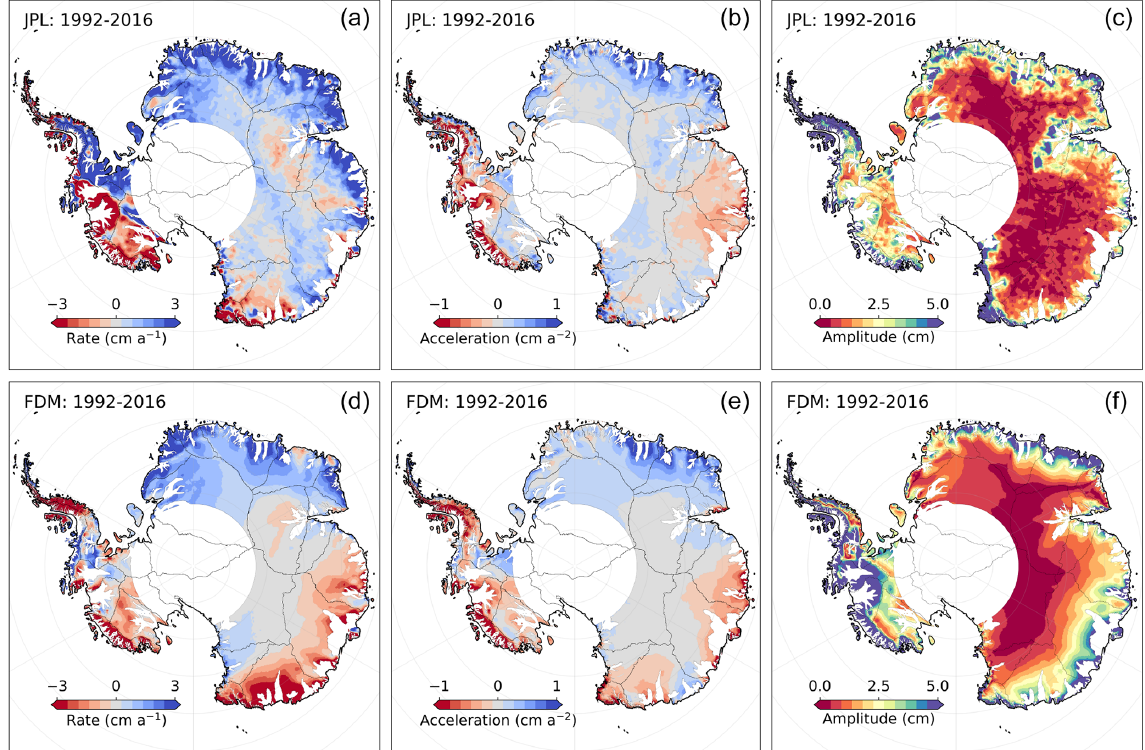
Figure 9. Spatial fields of rates (a, d) , acceleration (b, e) and seasonal amplitudes (c, f) from our product (JPL; a–c ) and modeled values from the IMAU firn densification model (FDM; d–f ). Areas of fast flow ( > 30ma − 1 ) have been masked out to minimize height changes caused by changes in ice flow. The altimetry data has been smoothed with a 50km median filter to highlight large-scale spatial